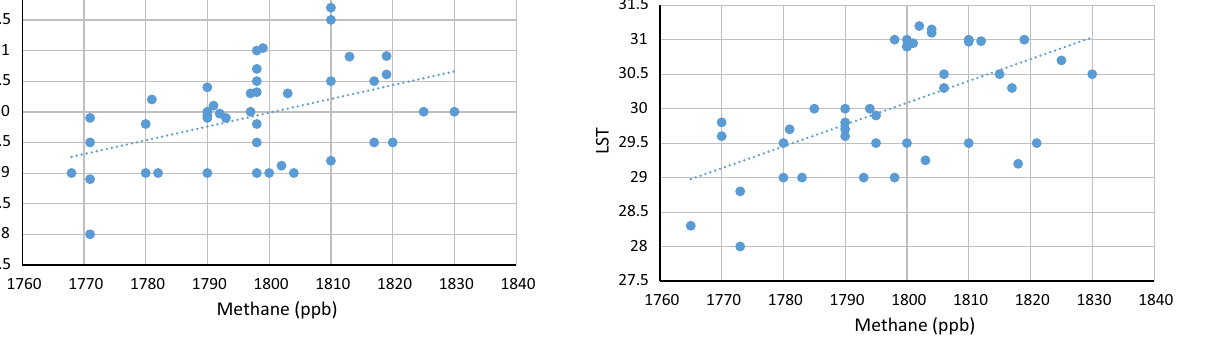
Fig. 10 Relationship between methane and LST in spring